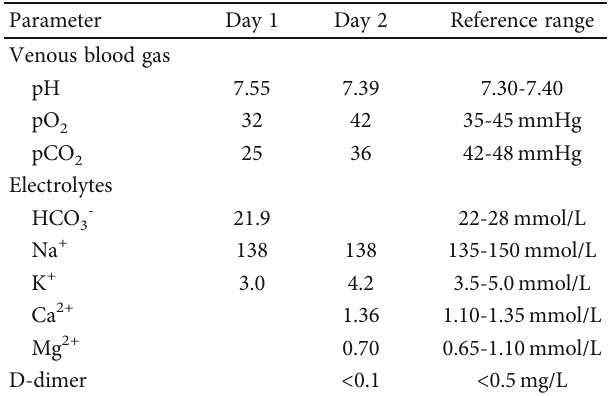
Table 1: Laboratory test results for case